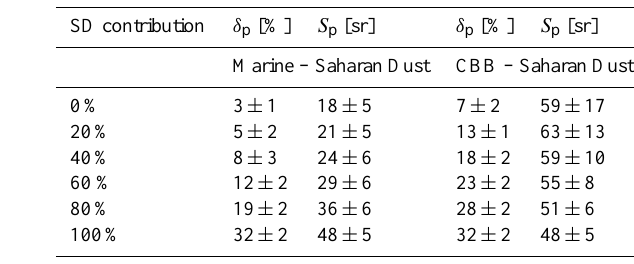
Table 3. Values of the particle linear depolarization ratio ( δ p ) and the lidar ratio ( S p ) calculated for selected mixing ratios of marine aerosol and Saharan dust, and of Canadian biomass burning aerosol (CBB) and Saharan dust. The Saharan dust contribution (SD con- tribution) refers to the fraction of Saharan dust to the total particle extinction coefficient at